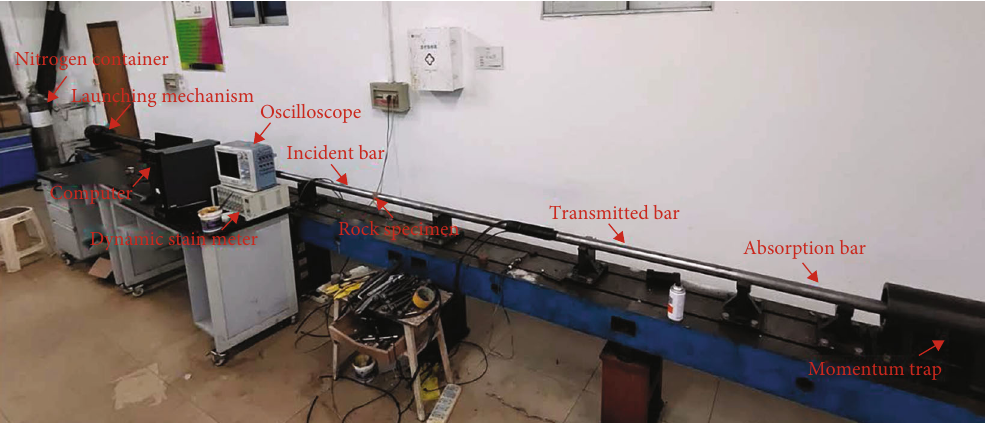
Figure 3: Photographic view of SHPB setup.